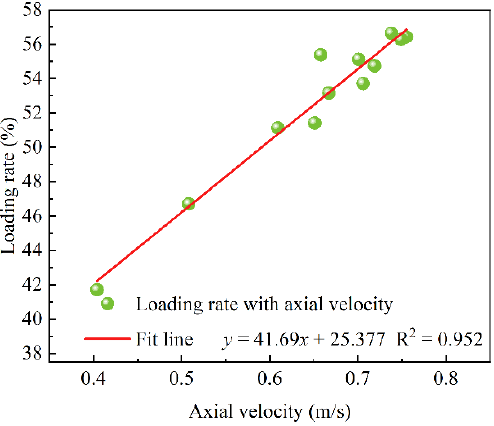
Figure 14. Particles’ axial velocities versus loading